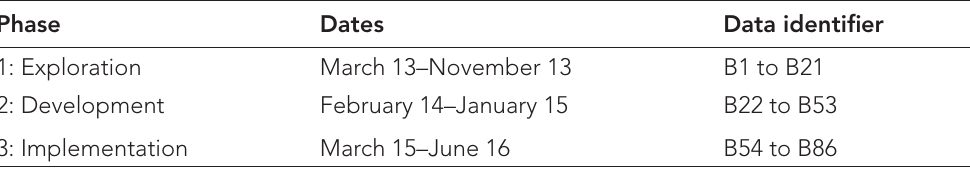
Table 2: Design-based research phases for analysis Phase